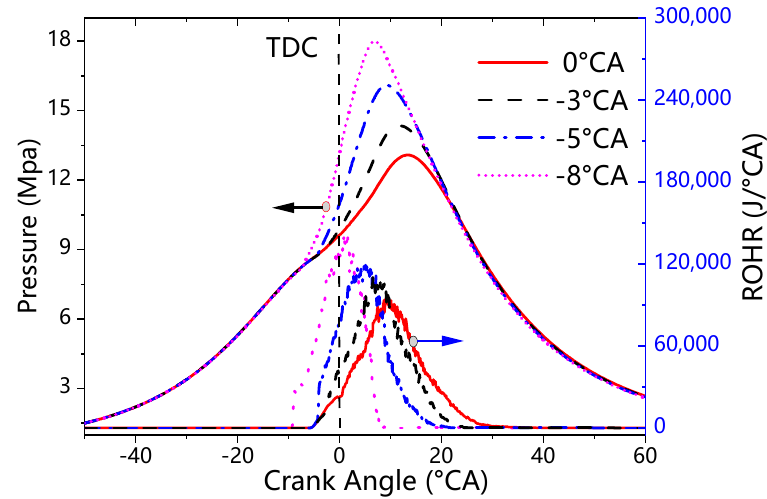
Figure 14. Pressure and heat release rate at di ff erent pilot start of injection (SOI) timing.